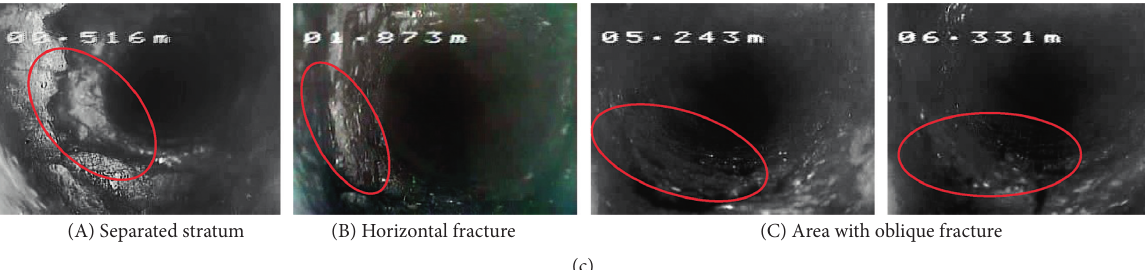
Figure 15: States of strata observed from boreholes at observation stations #1–3. (a) State of strata observed from borehole at observation station #1. (b) State of strata observed from borehole at observation station #2. (c) State of strata observed from borehole at observation station #3.